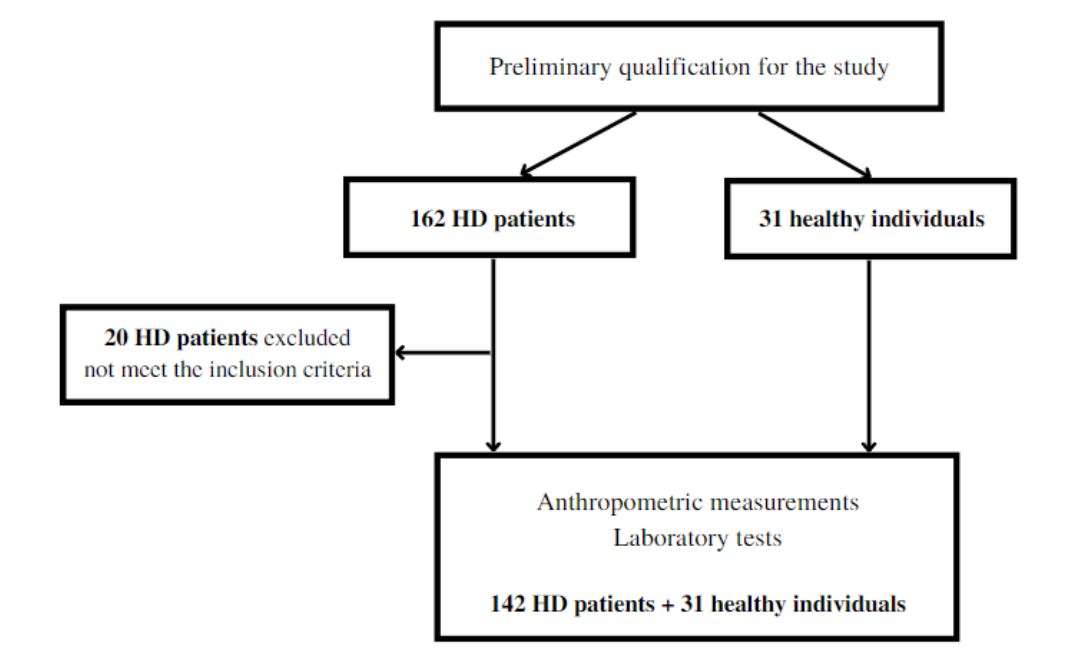
Figure 1. Scheme of the study.